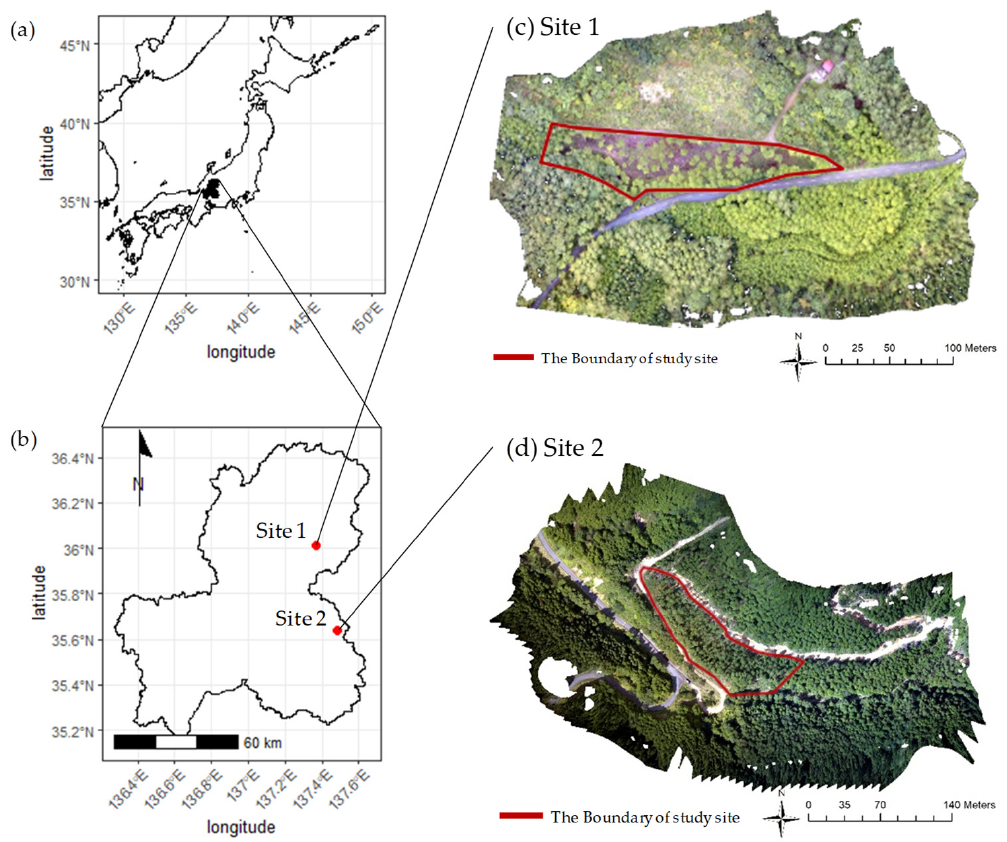
Figure 2. Location of the study sites per Fujimoto et al. [6] (Figure 1). ( a ) Gifu prefecture is located in the middle of Japan. ( b ) Red plots represent the locations of two study sites. ( c , d ) Orthographic photos of Sites 1 and 2. Red lines show the boundaries of the study sites.